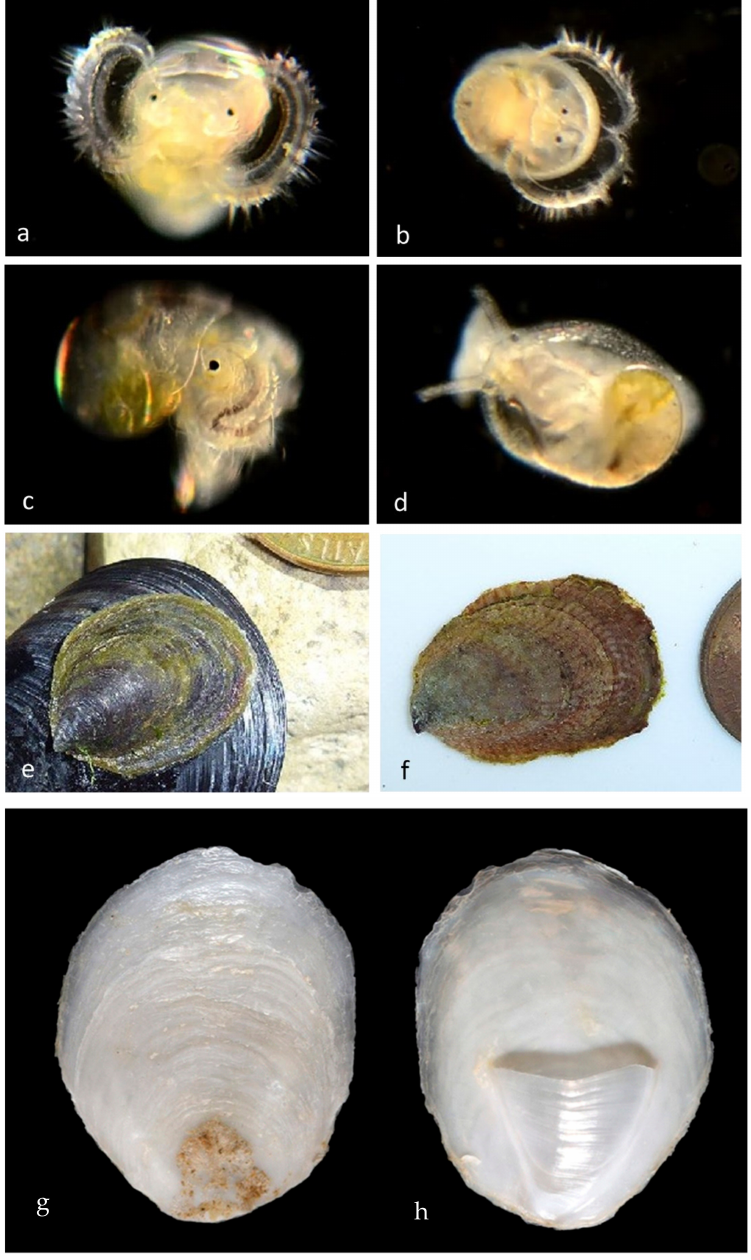
Figure 6. Family Calyptraeidae. Slipper snail , Crepidula huertae (= Crepidula cf. perforans ). ( a ) Veliger CCDB 31597 G03 from Newport Harbor entrance. ( b ) Adult CCDB-32336 D10 from inside the empty shell of a Bubble Snail ( Bulla gouldiana ) from Balboa at Coral. ( c ) Adult CCDB-32336 E01, 2&3 inside the empty shell of the same Bubble Snail ( Bulla gouldiana ). ( d ) Adult CCDB-32336 D10 and CCDB-32336 E01, 2&3 ventral views, live animals (no DNA sequences obtained). ( e ) CCDB-32336 D10 shell—ventral view. ( f ) CCDB-32336 E01, 2&3 shell—ventral view. ( g , h ), adult FMNH 282243. Subtidal in hermit crab shells, from Naples Reef, near Santa Barbara, Santa Barbara County, California. Length 30 mm [10]. We have found many stages of a different species of Slipper snail, Crepipatella lingulata . (Figure 6) which also has yellow spots on the